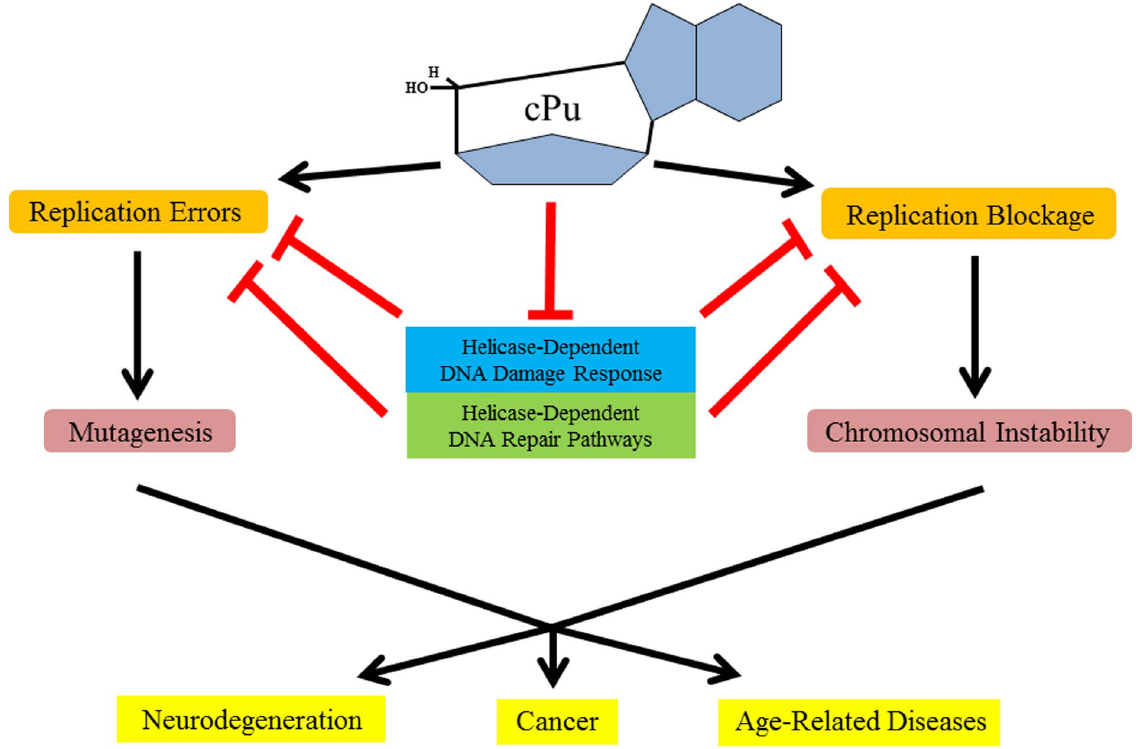
Figure 10. The accumulation of cyclopurine lesions in genomic DNA can cause replication errors or blockage leading to deleterious effects on the fidelity of DNA synthesis and maintenance of genomic stability which have negative outcomes for human health. The functions of certain DNA helicases can be adversely affected by cyclopurines and other forms of DNA damage which potentially impair helicase- dependent DNA damage response and repair pathways. See text for details.